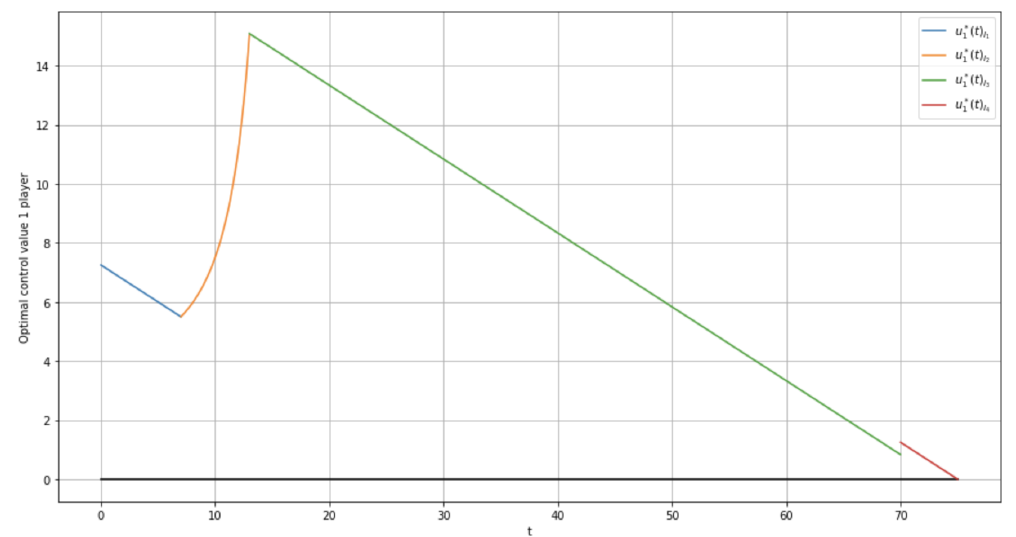
Figure 2. The optimal control of the first player on four time subintervals.